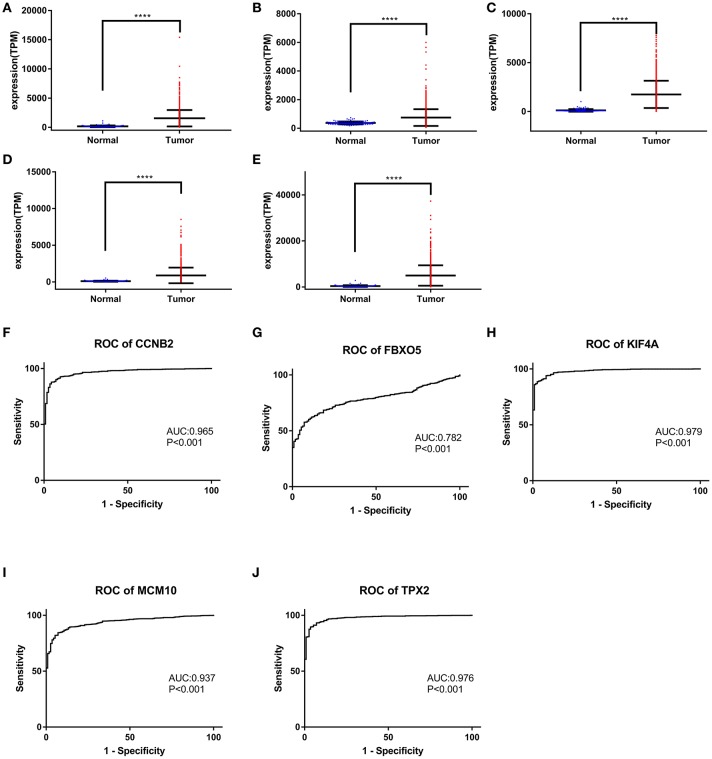
Gene expression levels of CCNB2, FBXO5, KIF4A, MCM10, and TPX2 between normal breast and tumor samples. The mRNA levels of CCNB2 (A), CCNB2 (B), FBXO5 (C), KIF4A (D), and TPX2 (E). ROC curve of CCNB2 (F), FBXO5 (G), KIF4A (H), MCM10 (I), and TPX2 (J). (A–E)
*P < 0.05; **P < 0.01; ***P < 0.001; ****P < 0.0001. Two-tailed Student's t-tests was used to evaluate the statistical significance of differences.